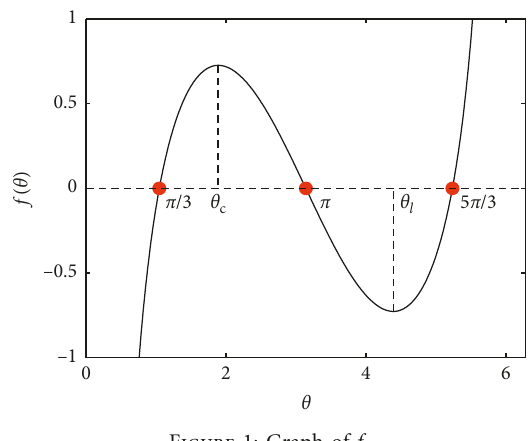
Figure 1: Graph of f